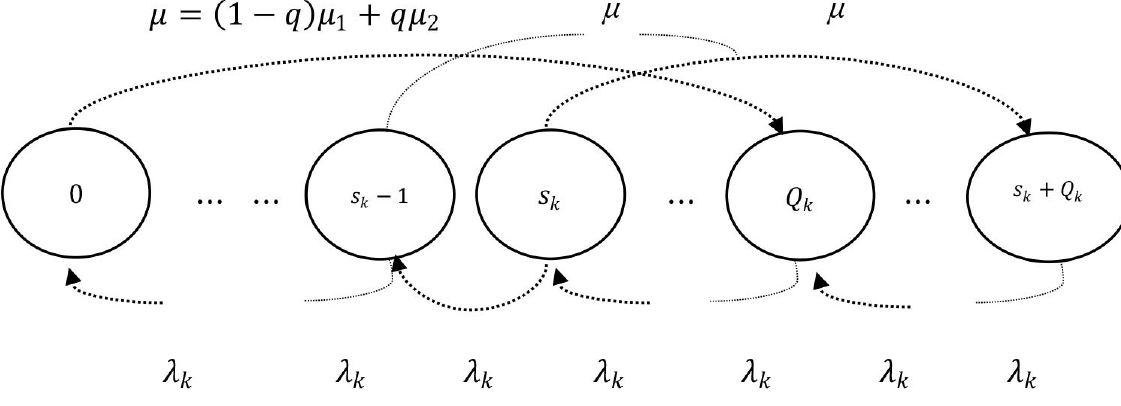
Figure 3. The rate transition diagram for on-hand